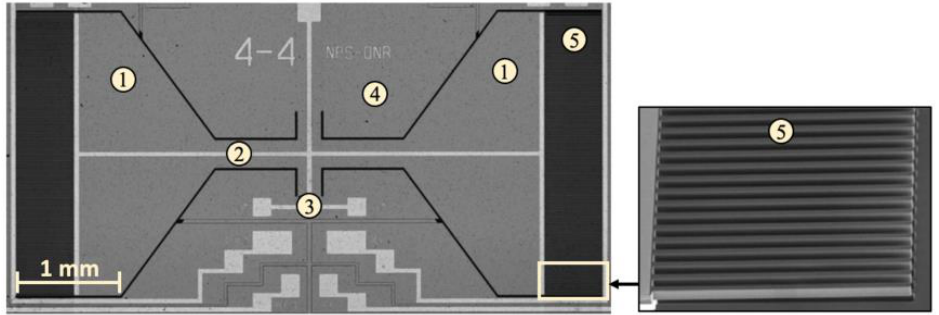
Figure 1. Optical micrograph of the MEMS sensor with comb finger capacitors attached to the edges of the wings. (1) Wings; (2) bridge; (3) leg; (4) substrate; and (5) interdigitated comb fingers.